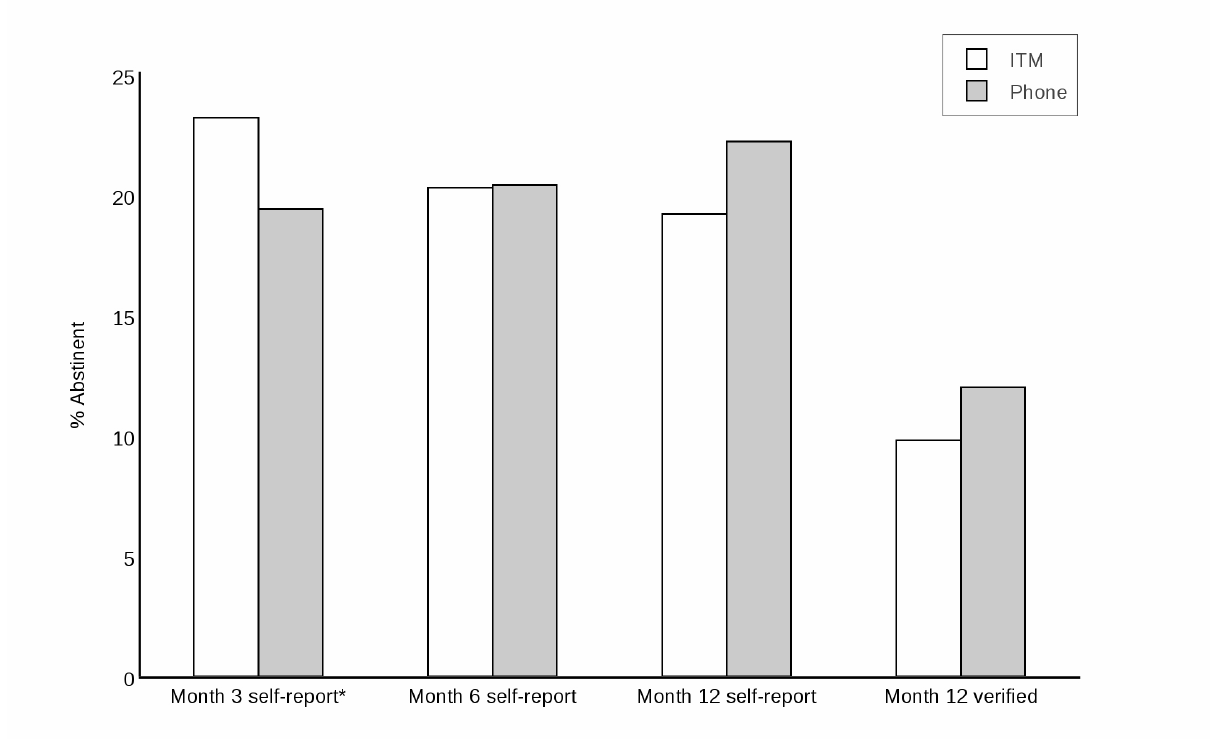
Figure 2. Primary